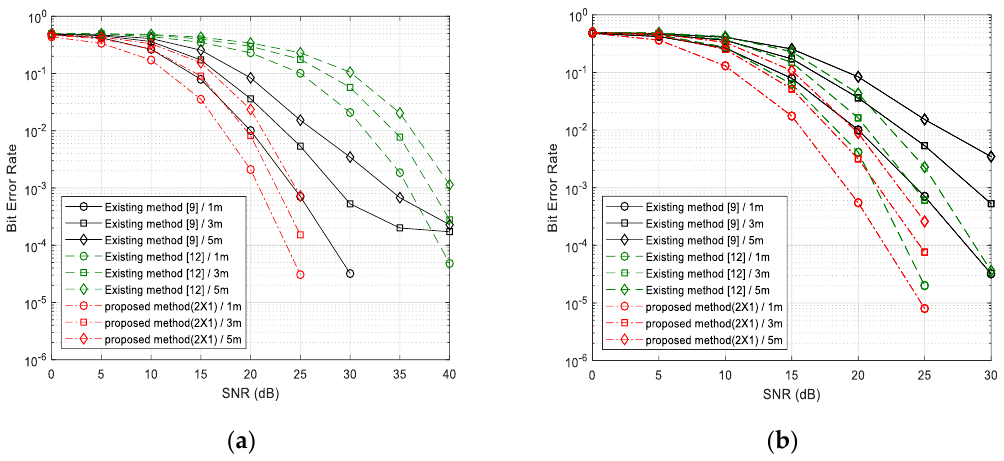
Figure 4. BER (bit error rate) performance for the existing and the proposed backscatter method. ( a ) Proposed MIMO (multiple-input multiple-output) encoding/decoding algorithm for increasing the data rate (the first method); ( b ) proposed MIMO encoding/decoding algorithm for improving the reliability (the second method).